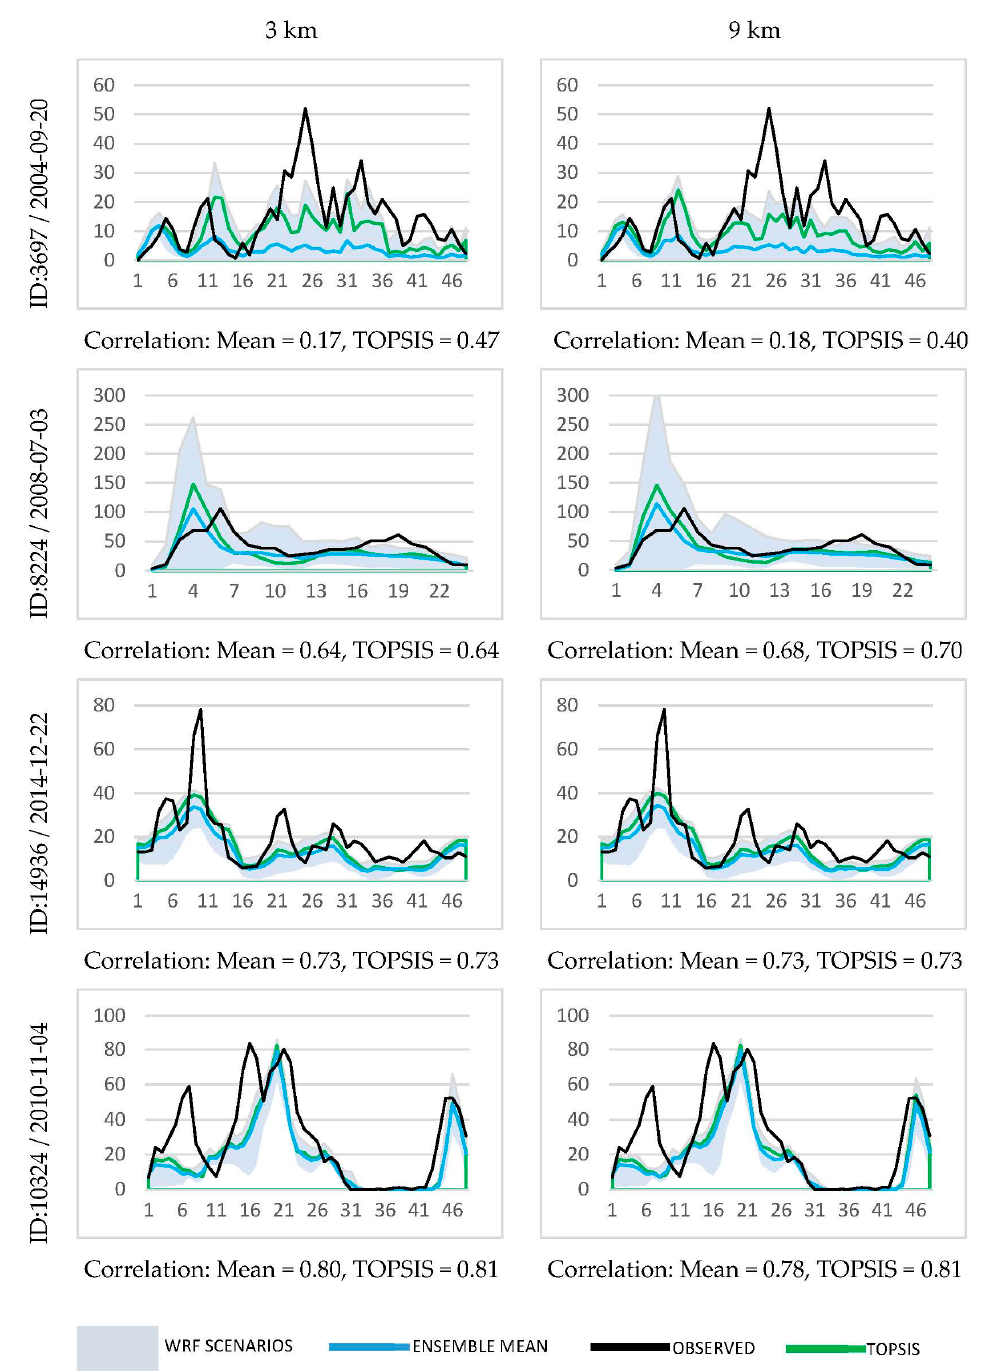
Figure 2. Hourly evolution of precipitation for the 3 and 9 km simulation results for the Schleswig– Holstein area. Black line—observed area-averaged precipitation for each distinct event; light blue line—average WRF-derived precipitation of all members; green line—average top-five-performing configurations according to TOPSIS; gray area—dispersion of average precipitation values from the various setups that were used to perform the simulations (vertical axis units are mm and horizontal axis units are h).